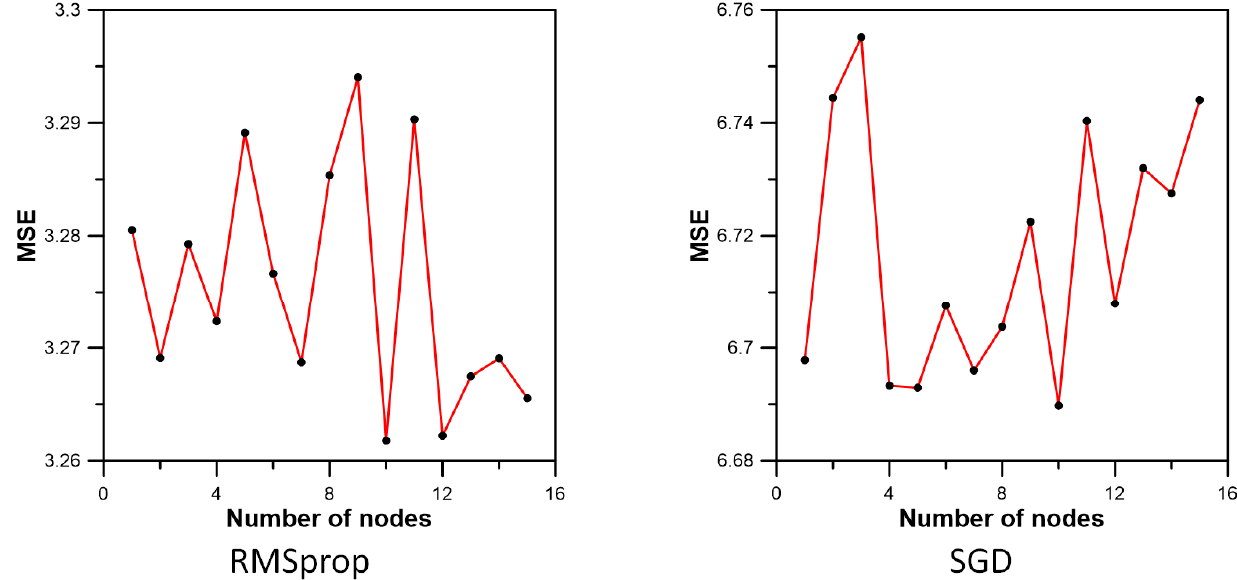
Figure 14. Results according to the number of nodes (RMSprop and SGD).